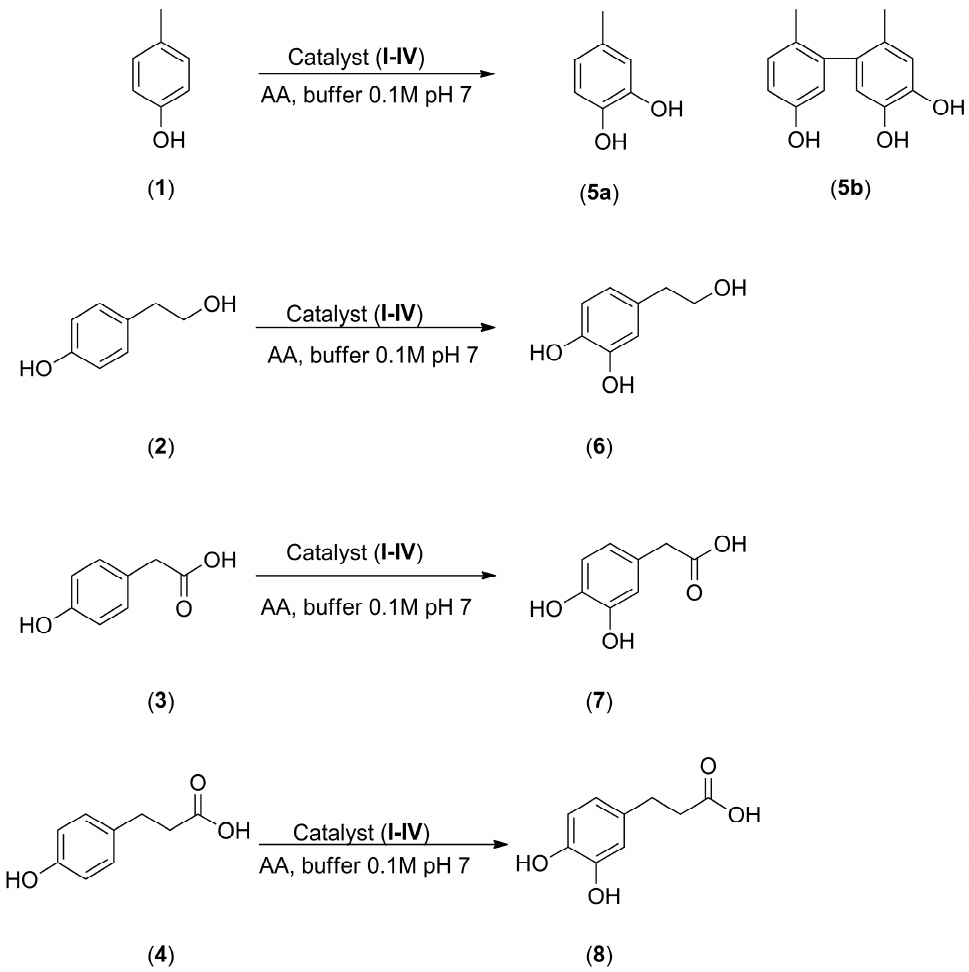
Figure 3. Confocal images of ( a ) Catalyst I ; ( b ) Catalyst II .